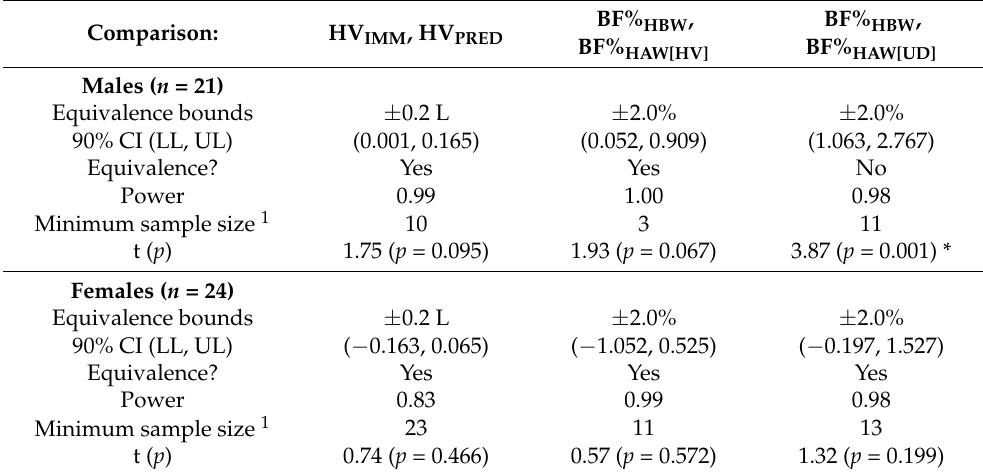
Table 3. Equivalence tests and t -tests for predicted head volume and body fat percent.